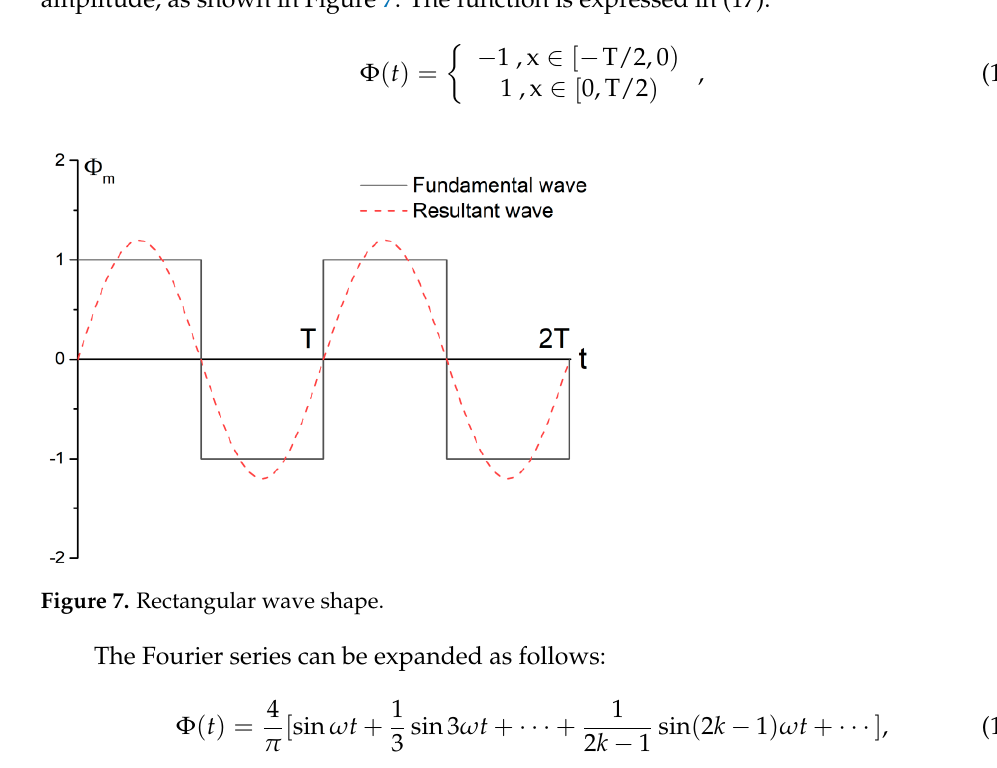
Figure 7. Rectangular wave shape.